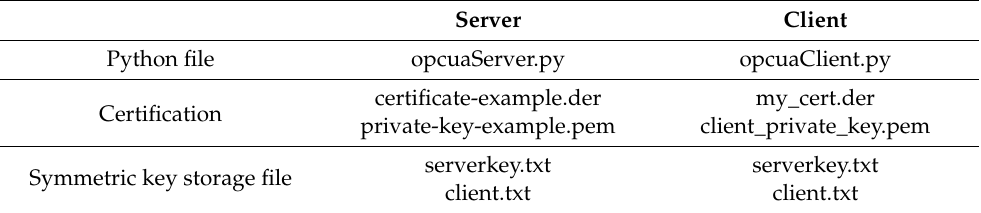
Table 16. Attack types and attack descriptions based on the attack tree.